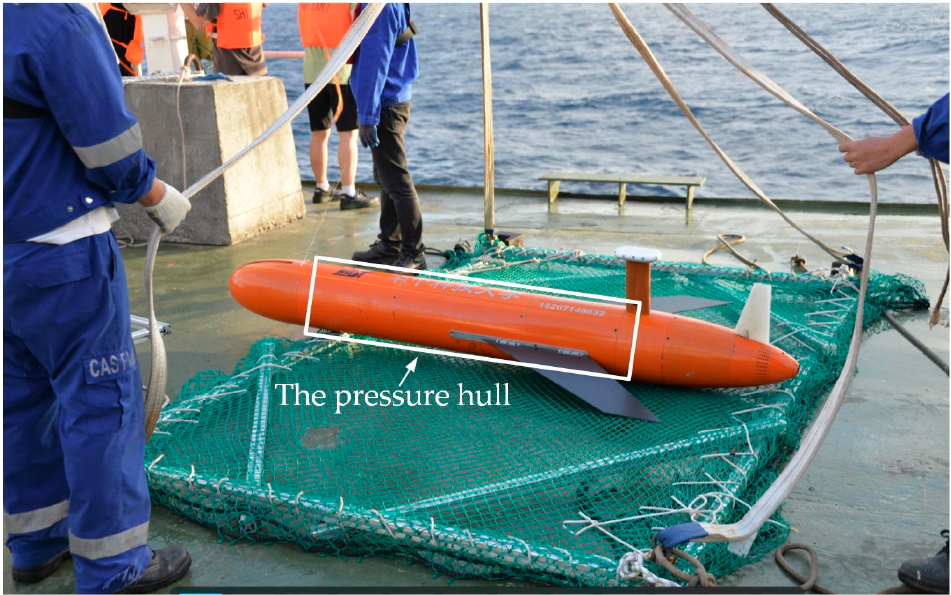
Figure 13. The physical picture of pressure hull.